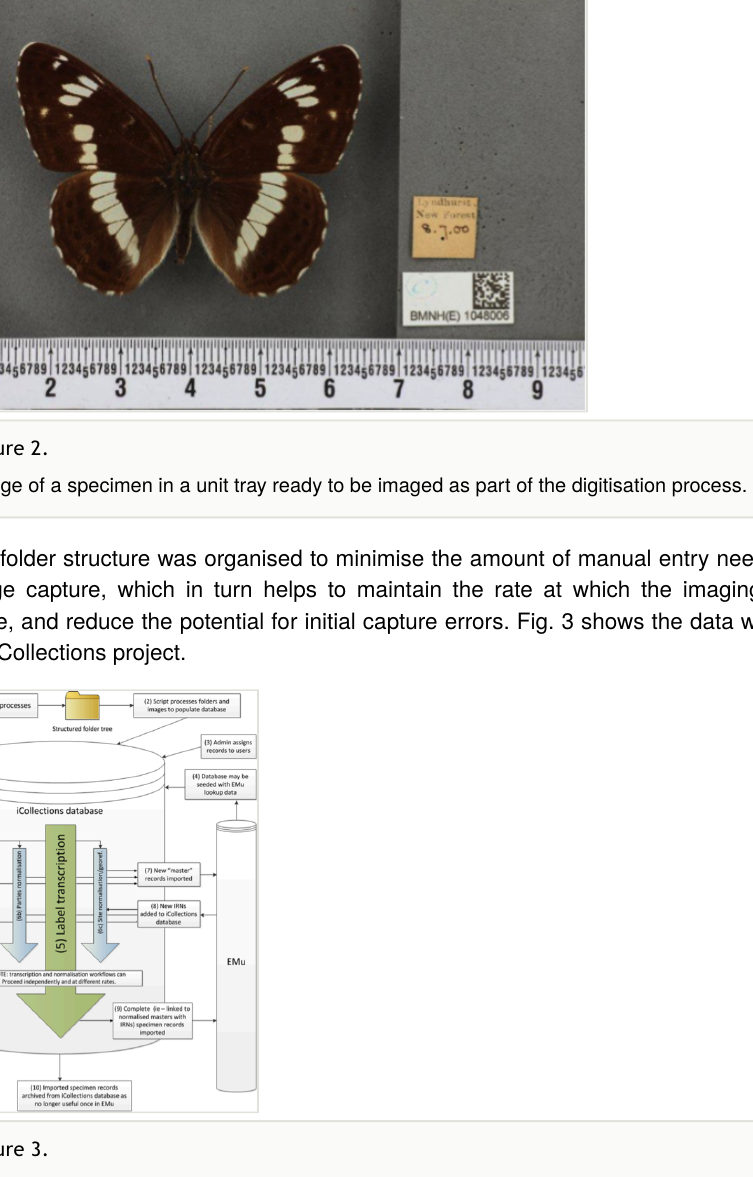
Work fl ow associated with the iCollections digitisation